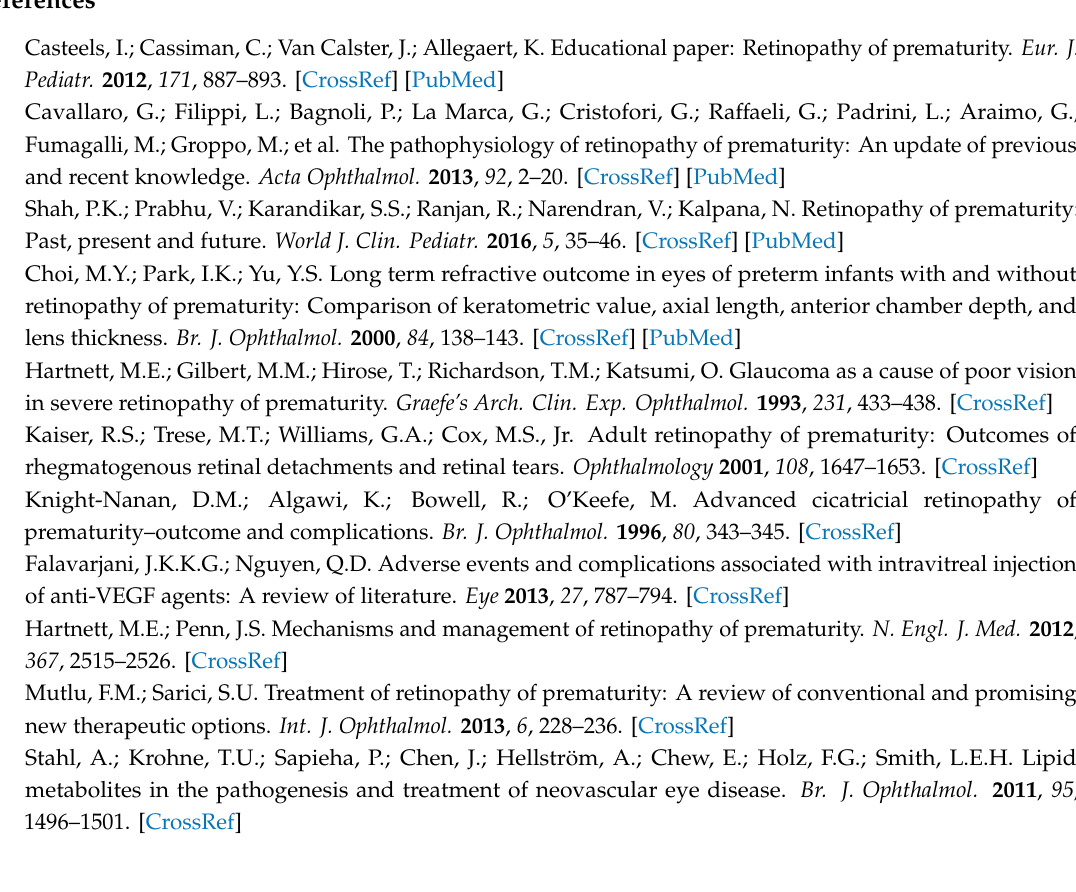
Figure S1: E ff ect of UDCA on the viability of Human retinal endothelial cells, Figure S2: UDCA does not induce systemic toxicity in